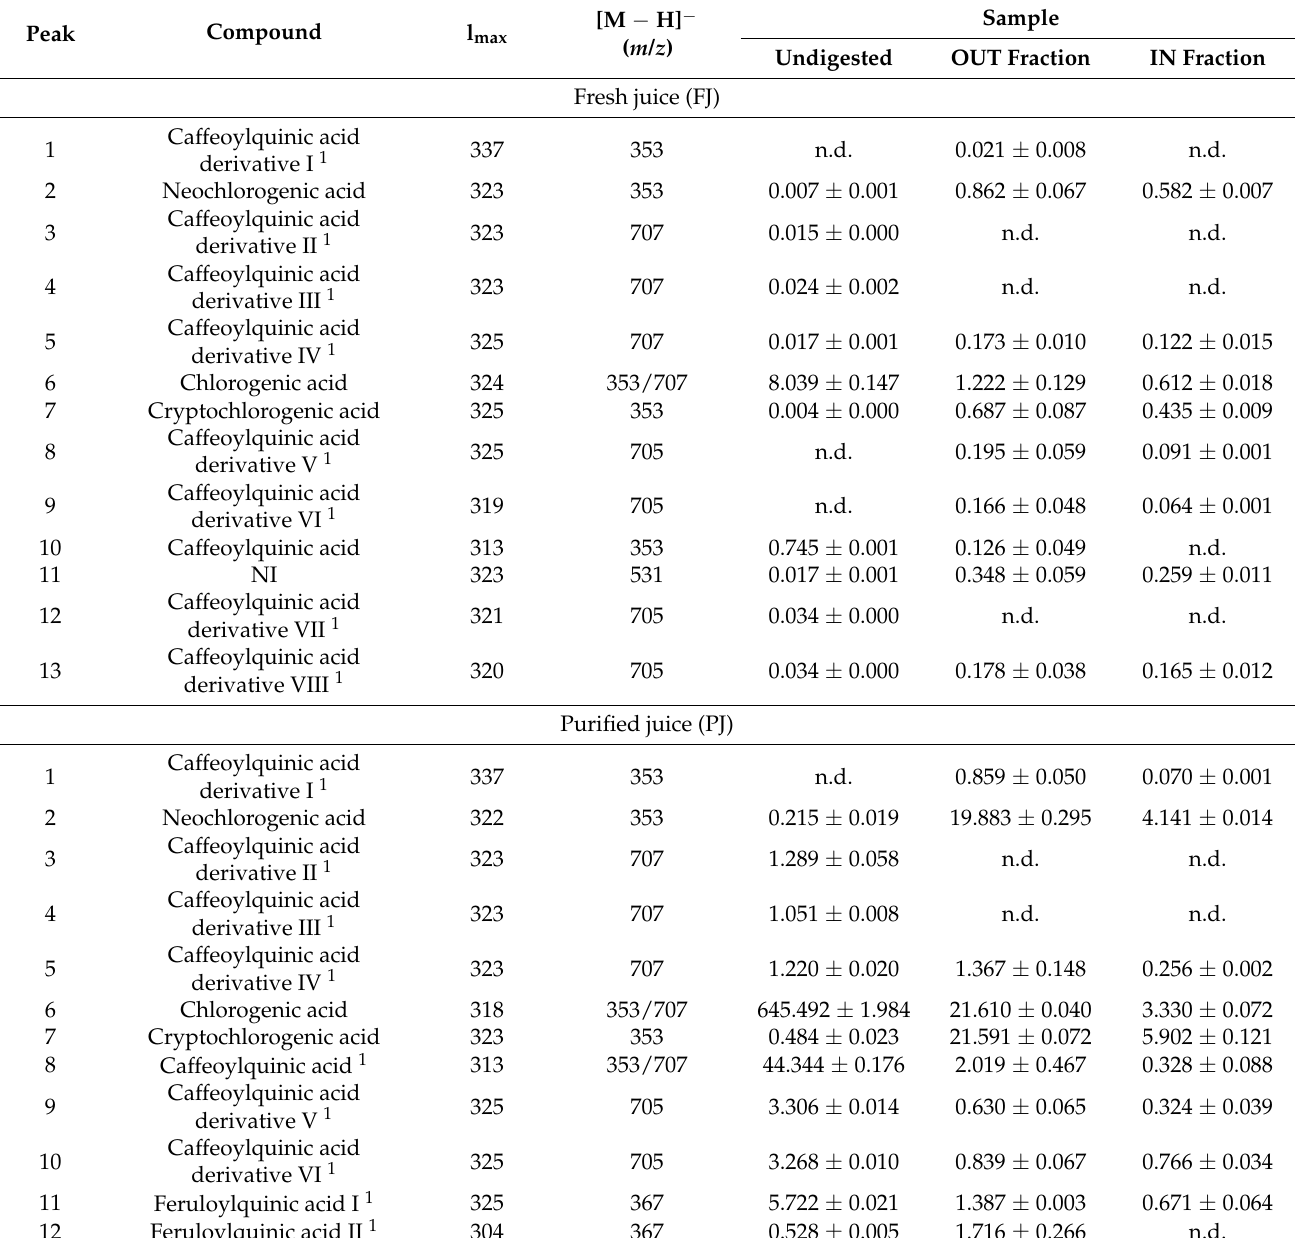
Table 1. Quantification of individual hydroxycinnamic acids (mg/g undigested sample) in V. opulus fresh juice (FJ) and purified juice (PJ) before and after in vitro